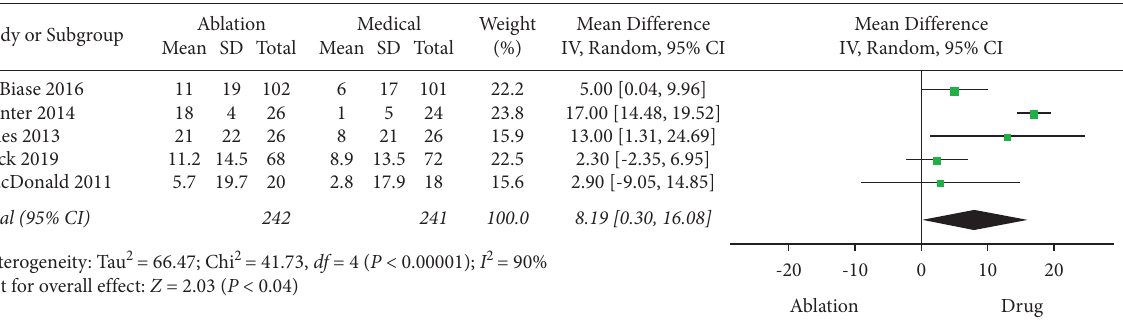
Figure 6: Forest plot of CA versus medical therapy: MLHFQ